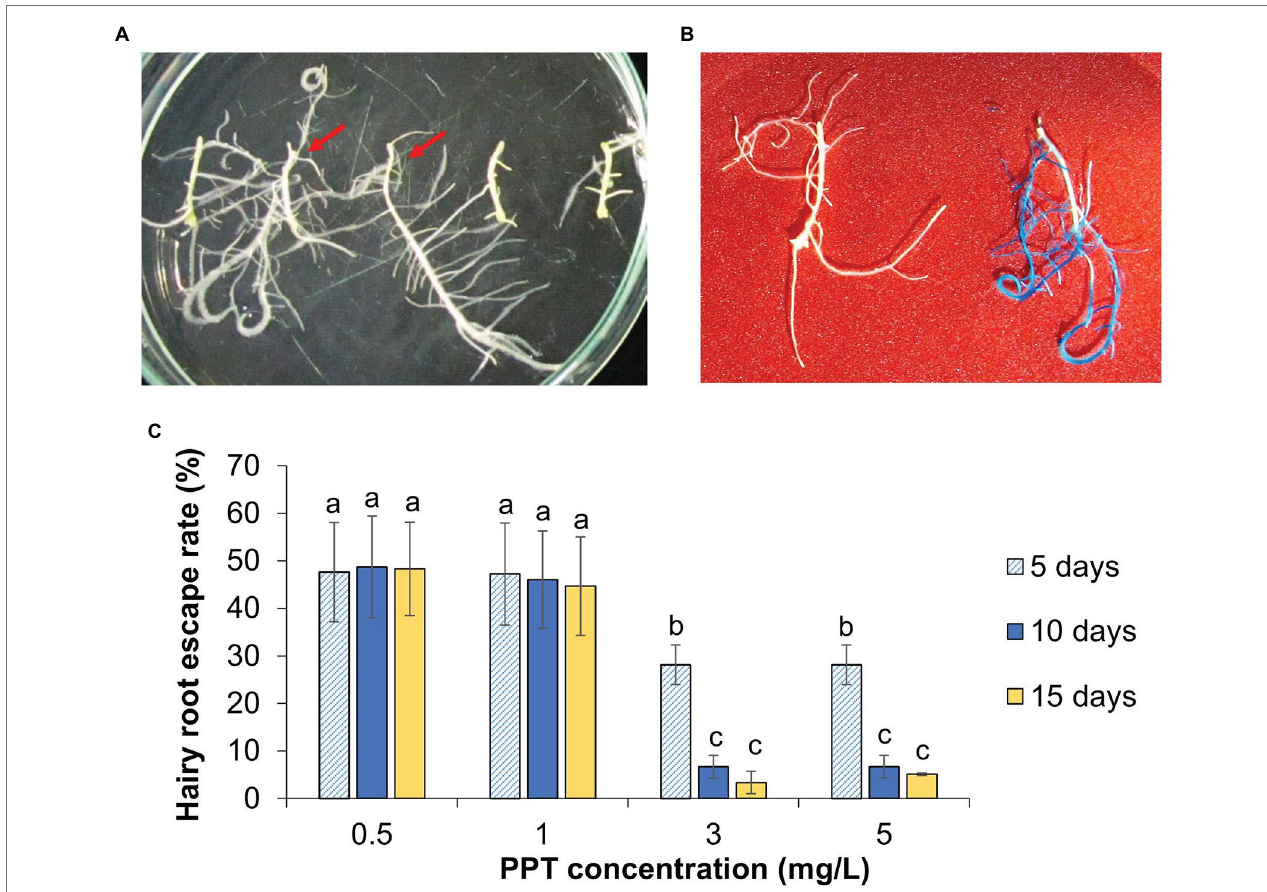
FIGURE 4 | The transgenic hairy root selection and histochemical analysis. (A) Hairy roots at 10 days on selection medium supplemented with 3 mg/L PPT. The red arrows indicate the PPT resistant hairy roots. (B) GUS histochemical analysis of non-transgenic (left) and transgenic hairy roots (right). (C) Effect of PPT concentrations on the selection efficiency. The escaped hairy roots are referred to the PPT resistant hairy roots without GUS staining. Data are presented as mean ± SD of three replicates. Different letters indicate significant differences based on one-way ANOVA analysis with Duncan’s test ( p < 0.05, n =